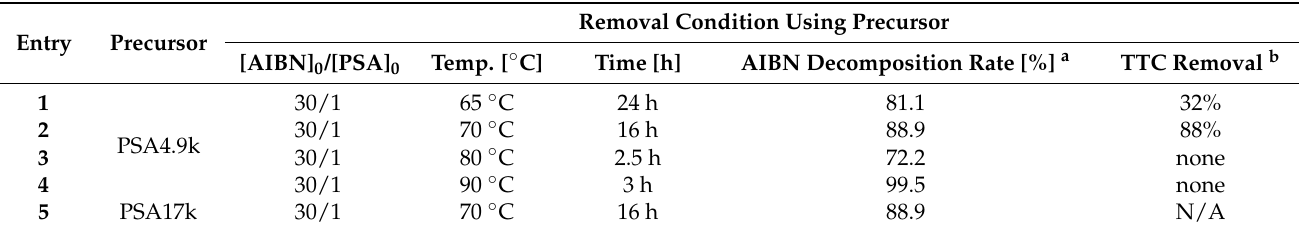
Table 2. TTC removing reaction from RAFT-polymerized PSA.